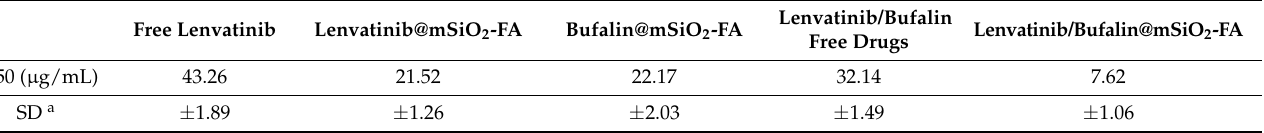
Table 3. IC50 values of different various drug formulations in 9810 cells measured by CCK8